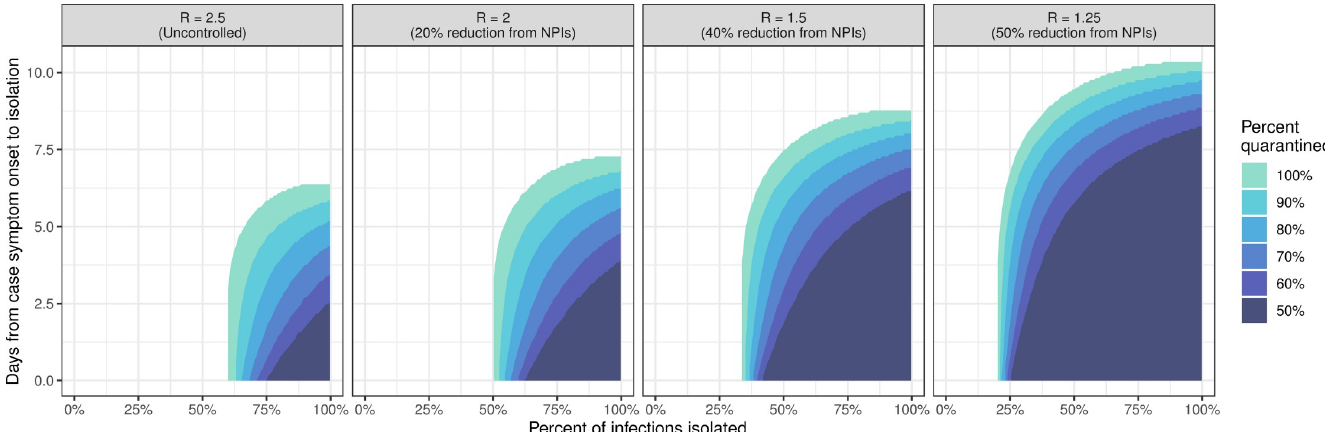
Fig 4. Isolation strategies (timing and completeness) capable of achieving R < 1 when a given proportion of contacts (50% to 100%) are quarantined on the same day as case isolation. These strategies are shown for 4 possible baseline values of R , assuming other nonpharmaceutical interventions (NPIs) are in effect to reduce transmission from the uncontrolled scenario, R =